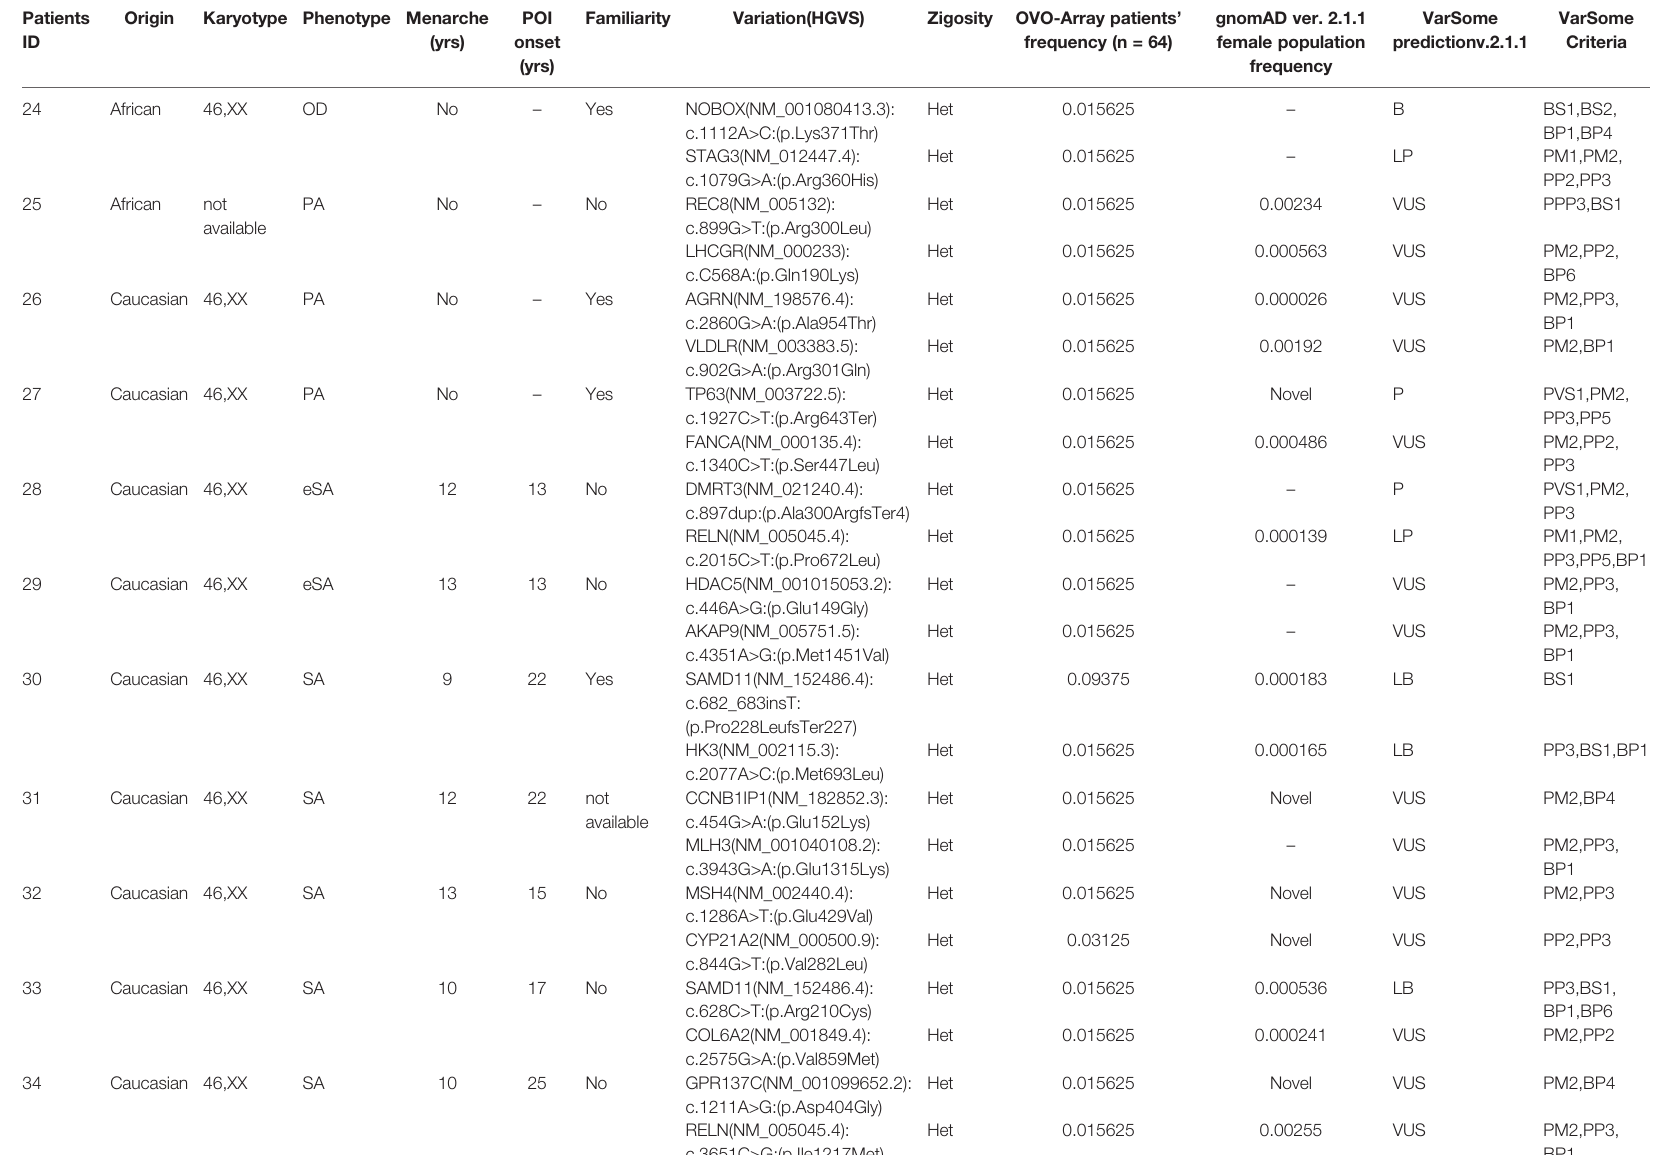
TABLE 5 | Correlation among severity, phenotype and pathogenicity predictions in patients with 2 variants in potentially POI